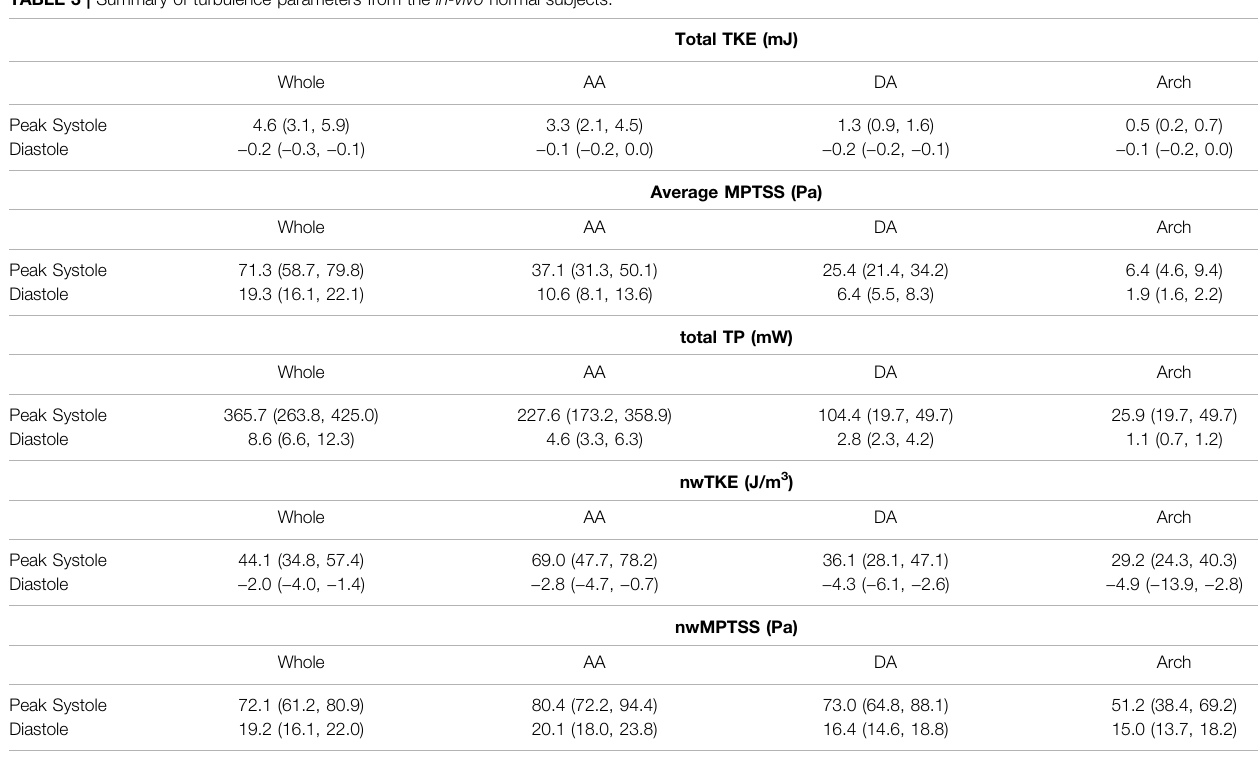
TABLE 3 | Summary of turbulence parameters from the in-vivo normal